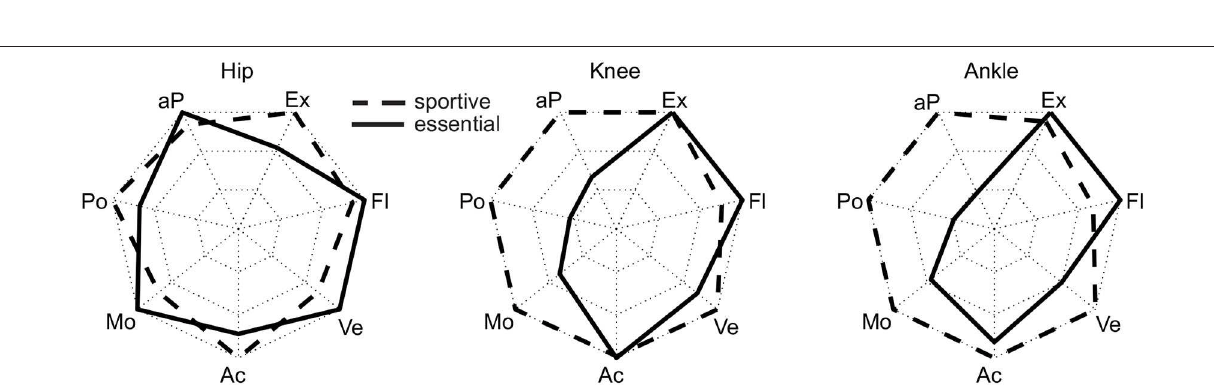
Frontiers in Robotics and AI |